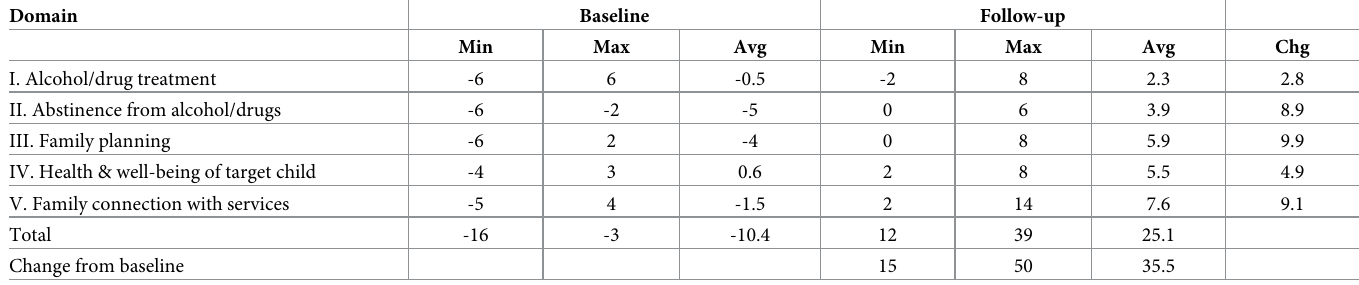
Table 2. ASI Scale Scores by Category, Baseline and at Follow-up.